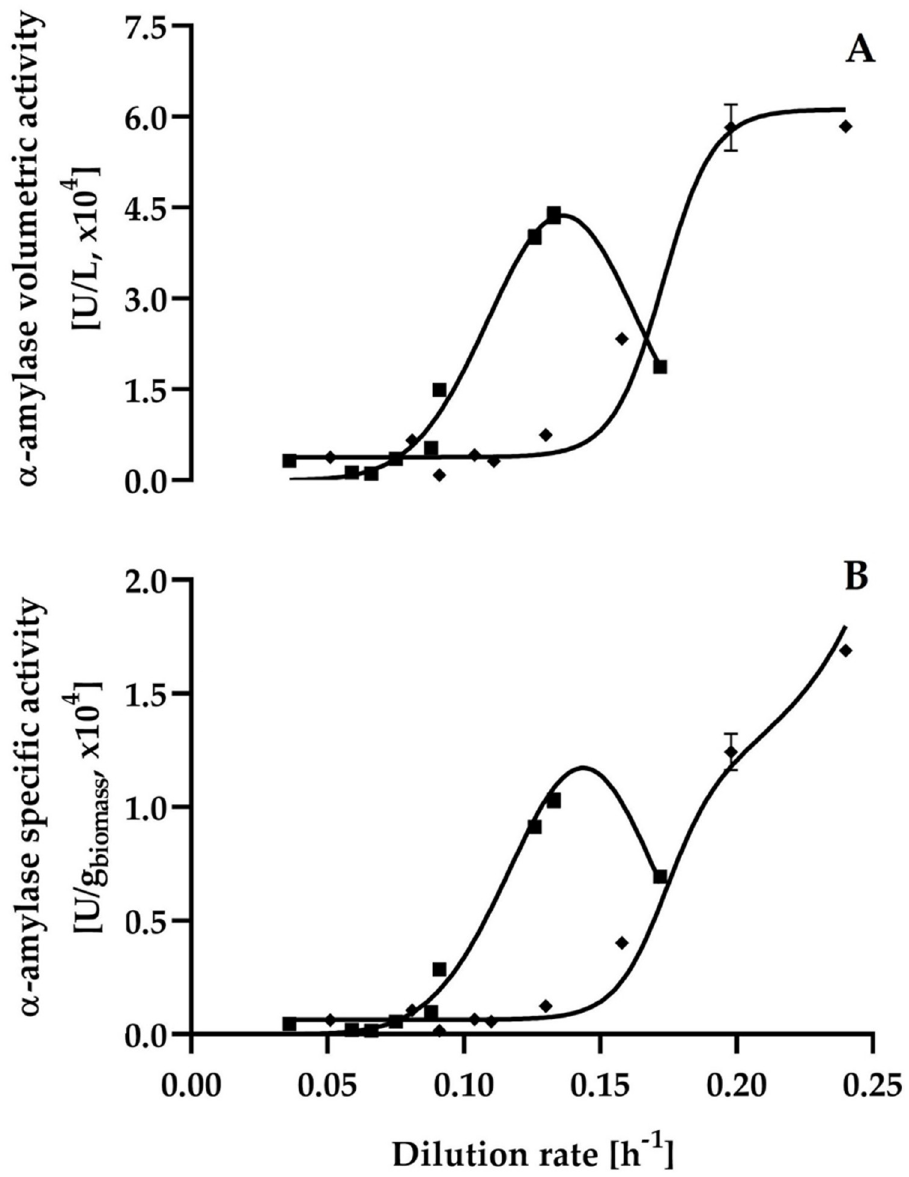
Fig 4. Steady-state α -amylase volumetric (A) and specific (B) activities versus dilution rate for continuous cultures of C . wangnamkhiaoensis . ◼ , maltose; ◆ ,